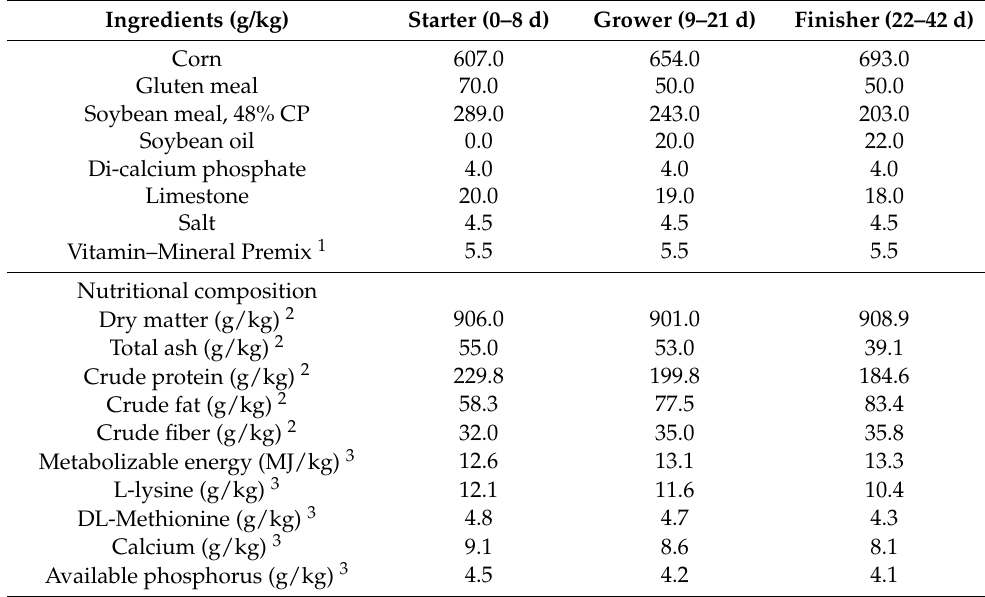
Table 2. The chemical characteristics of propolis and bee